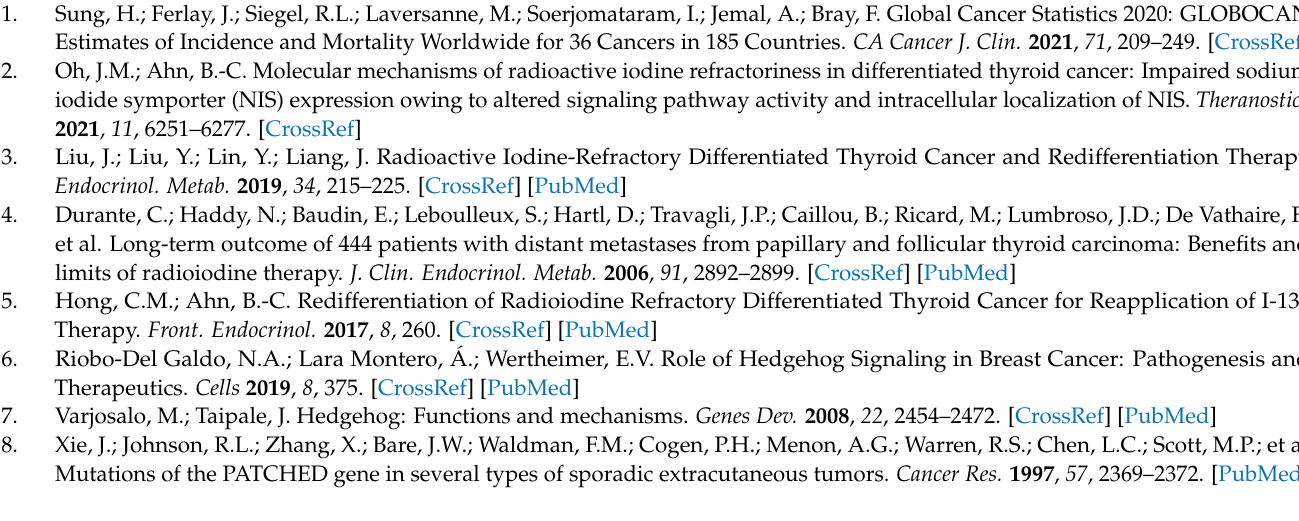
Figure 1B; Figure S4: Raw data of Figure 1C; Figure S5: Raw data of Figure 2A; Figure S6: Raw data of Figure 2B; Figure S7: Raw data of Figure 2C; Figure S8: Raw data of Figure 2D; Figure S9: Raw data of Figure 2G; Figure S10: Raw data of Figure 2H; Figure S11: Raw data of Figure 3A; Figure S12: Raw data of Figure 3B; Figure S13: Raw data of Figure 3C; Figure S14: Raw data of Figure 3D; Figure S15: Raw data of Figure 5B; Figure S16: Raw data of Figure 5D; Scheme S1: List of used primary antibodies for western blot